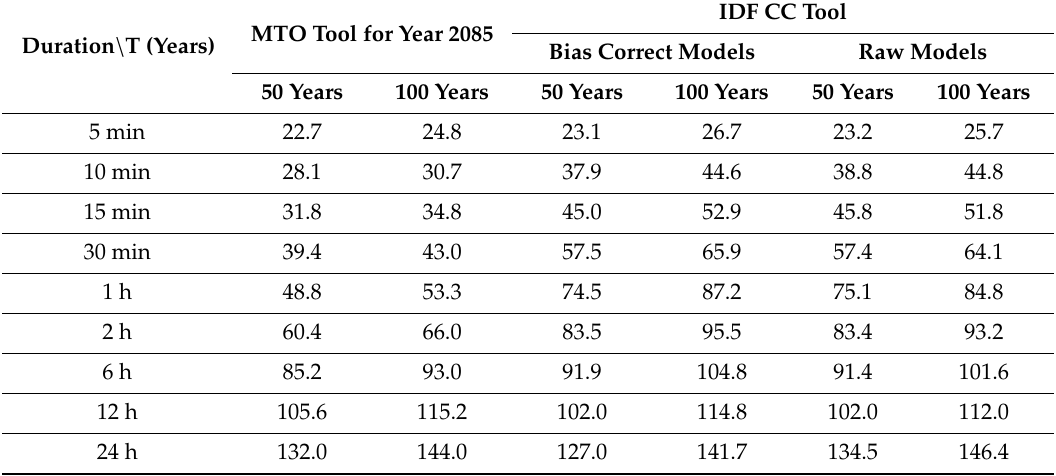
Table 2. Projection for London CS station, RCP 85—Period 2071–2100 using bias corrected models (values in